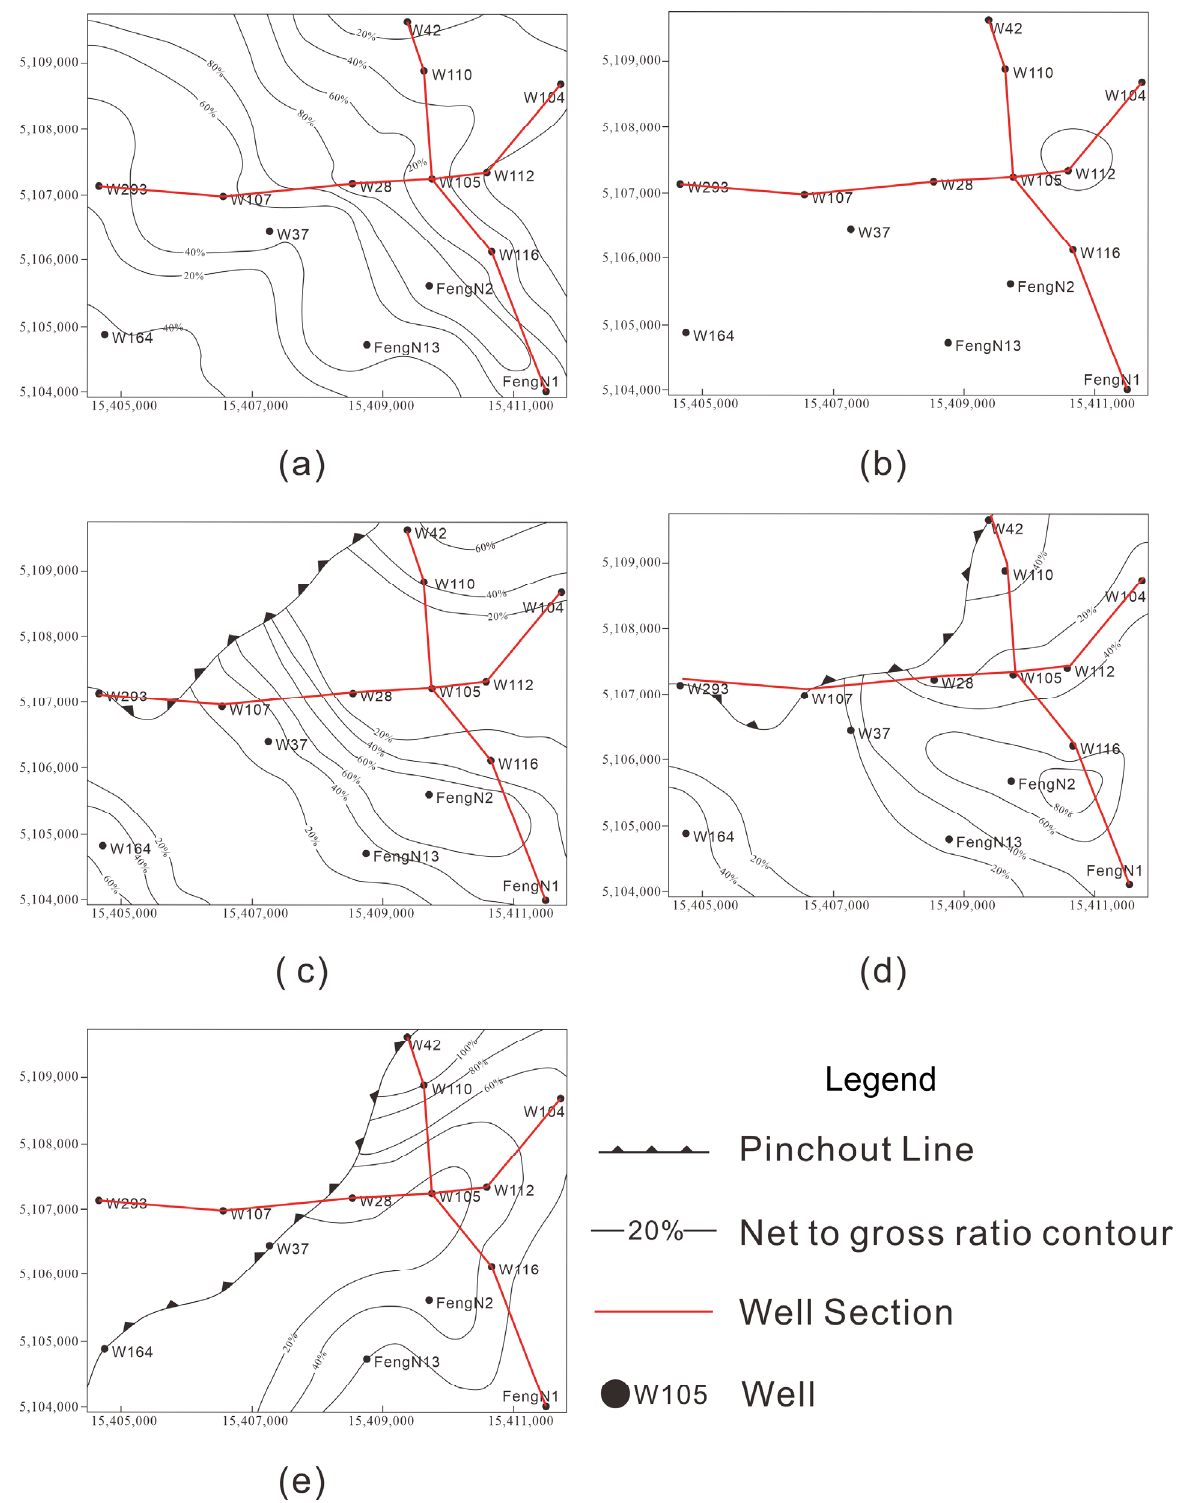
Figure 10. Contour map of the net to gross ratio of Jurassic strata in the study area: ( a ) Badaowan Formation; ( b ) Sangonghe Formation; ( c ) Xishanyao Formation; ( d ) Toutunhe Formation; ( e ) Qigu Formation.